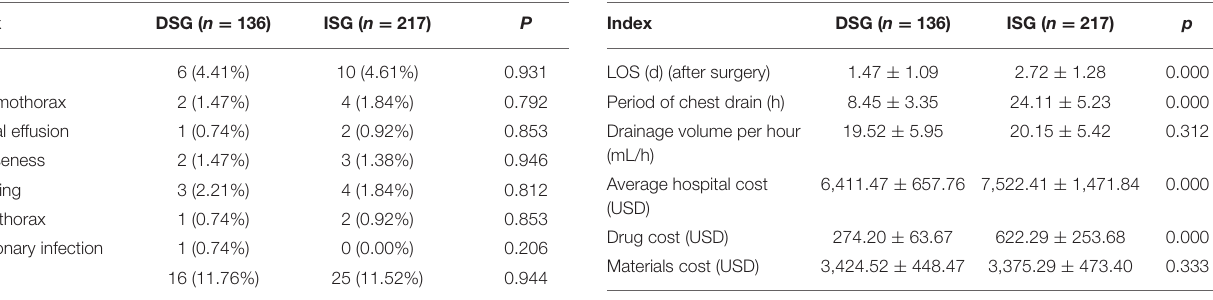
TABLE 3 | Treatment-related costs and resource consumption between two groups of